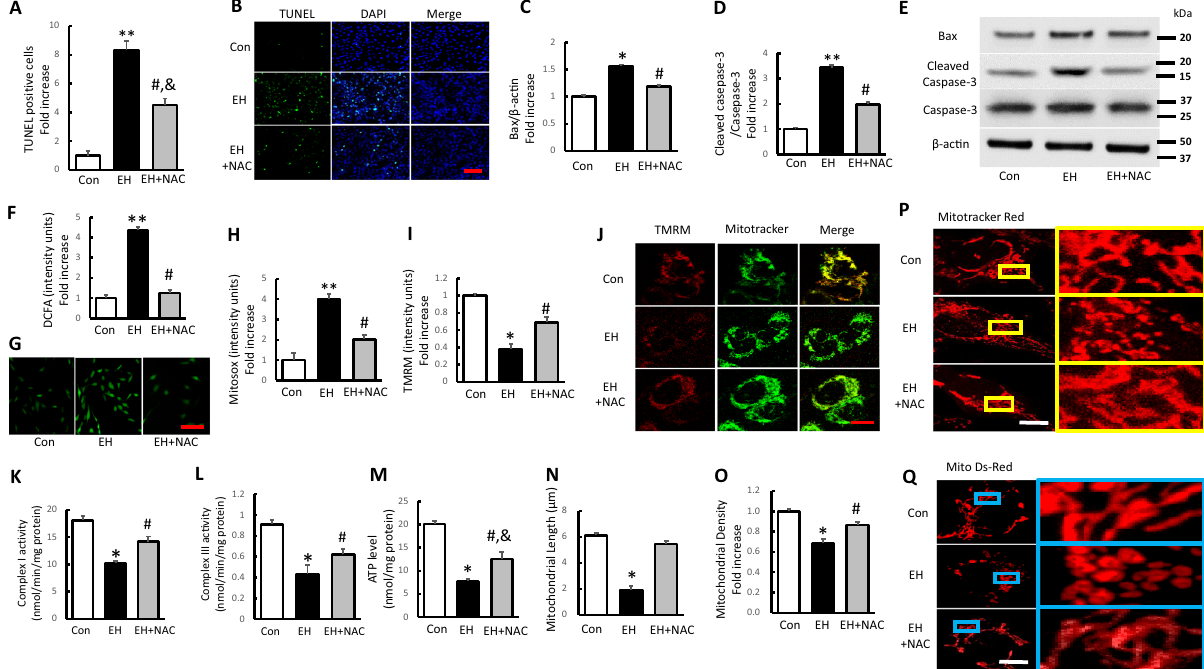
Figure 6. Effect of antioxidant treatment on EH-induced apoptosis and mitochondrial dysfunction in SH-SY5Y cells. ( A , B ) The TUNEL-positive cells presenting as fold increase and representative pictures for TUNEL/ DAPI-fluorescence staining (scale bar 200 μm) in indicated groups. ( C – E ) Quantification of immunoreactive bands for Bax relative to β-actin ( C ) and cleaved Caspase-3 relative to Caspase-3 ( D ). Immunoreactive bands for Bax, cleaved Caspase-3, and Caspase-3 in the different treated cells ( E ). ( F , G ) Quantitative analysis of DCFA fluorescence intensity presenting as fold increase and representative images (scale bar 50 μm) in the indicated groups. ( H – J ) Quantification of Mitosox and TMRM staining intensity ( H , I ) with representative images showing TMRM staining (scale bar 5 μm) in the indicated groups ( J ). ( K – M ) Complex I, III activities and ATP levels in the indicated groups. ( N – Q ) Quantification of mitochondrial length and density ( N , O ) with representative images of Mitotracker Red and Mito Ds-red staining (scale bar 5 μm) in the indicated groups ( P , Q ). Values shown as mean ± SD. *p < 0.05 and **p < 0.01 versus control group; # p < 0.05 versus EH group and & p < 0.05 versus control group (n =